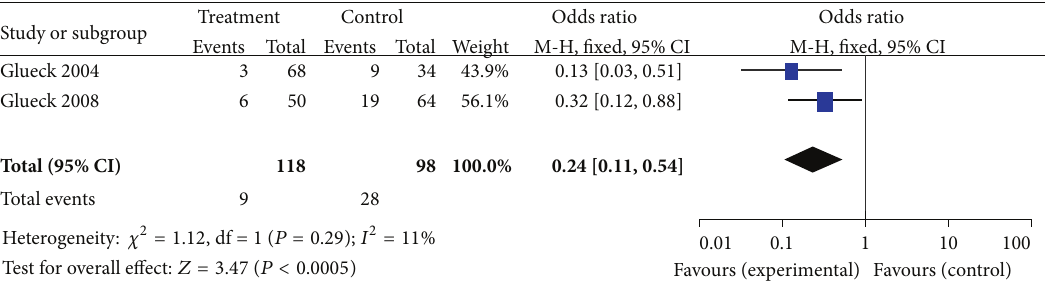
Figure 5: The meta-analysis of the odds ratio for gestational diabetes in the studies with patients’ selves as